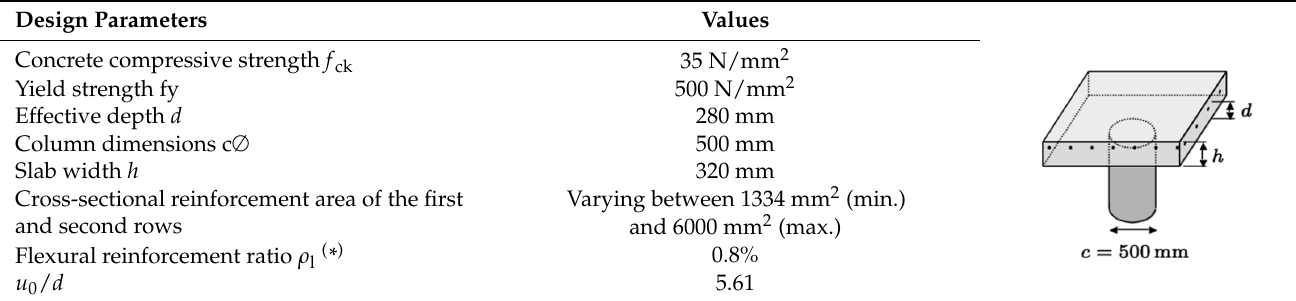
Table 4. Assumptions for the design of the structural system.